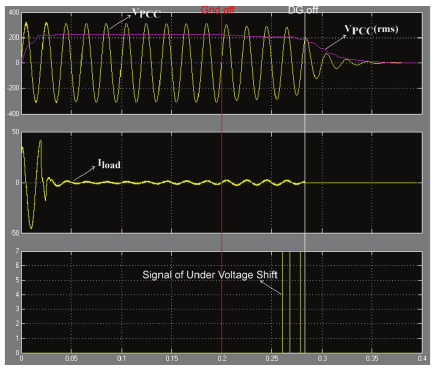
on undervoltage. PCC